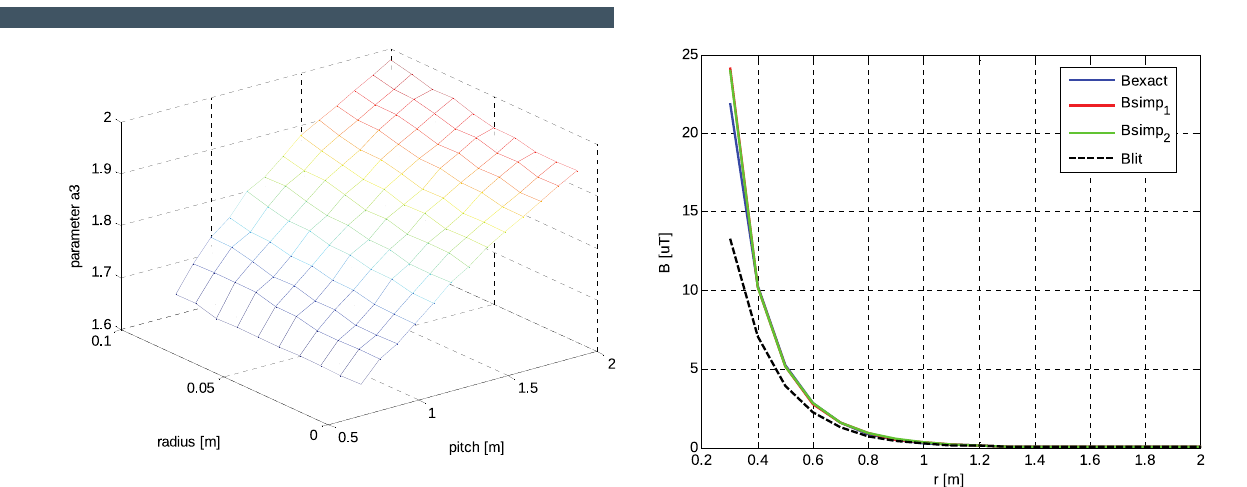
Figure 5. B exact , B simp 1 , B simp 2 , B lit versus distance r from the axis of the helix for the cable ARE4H1RX 12/20 kV 3 × 120 mm 2 in overhead line configuration in linear